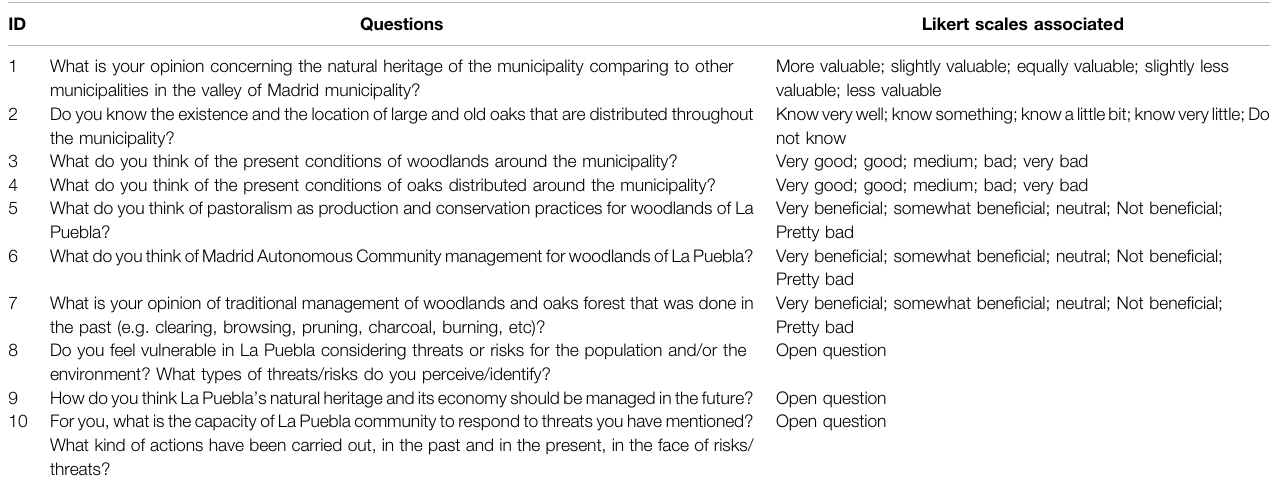
TABLE 4 | Questions and Likert scale associated of semi-structured interviews conducted in Puebla de la Sierra. During the data analysis, we considered the answers “ Equally valuable ” , “ Do not know ” , “ Medium ” and “ Neutral ” as corresponding to the same score, i.e., a neutral score (see Table 5